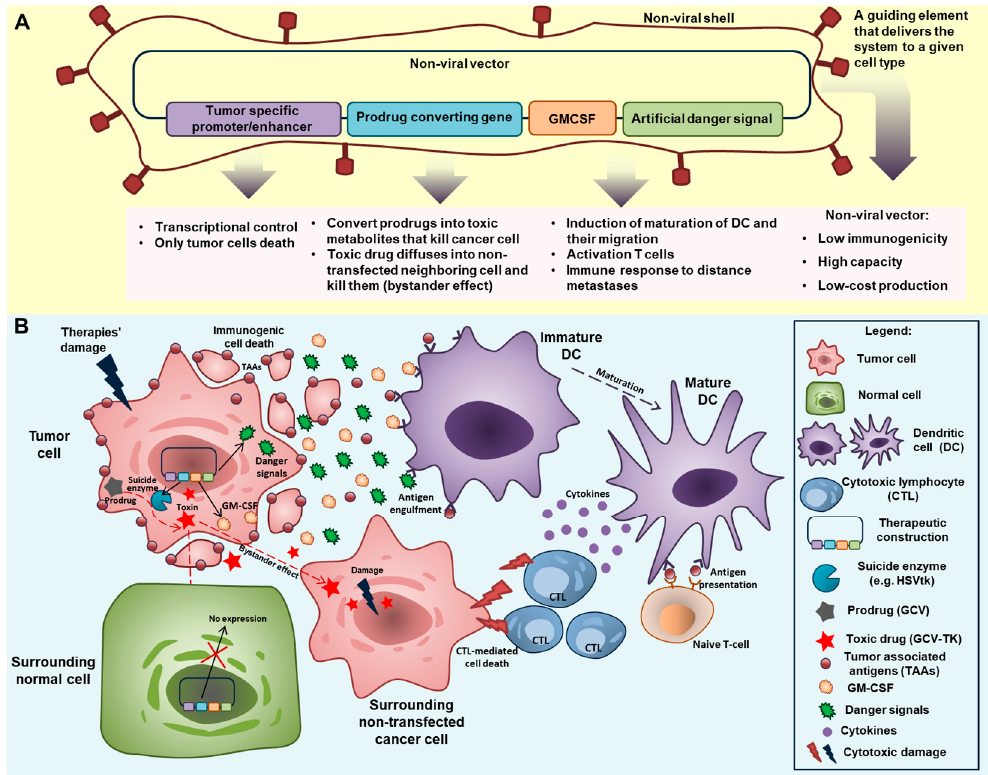
Figure 3. The “ideal” GDEPT system. ( A ) Components for improving the GDEPT system vector. A plasmid vector that encodes the suicide enzyme converting the prodrug to a toxin under the control of the tumor-specific promoter alongside GM–CSF plus an artificial danger signal as immunomodulators. The plasmid vector is coated by a non-viral shell with a guiding element that targets the system for a given cell type. ( B ) Mechanism of action of the “ideal” GDEPT system. A therapeutic construction administered intratumorally transfects the tumor cells because the guiding element of the non-viral shell and tumor-specific promoter/enhancer transgenes are restricted to expression in normal cells. In transfected tumor cells, the prodrug-converting gene (suicide enzyme gene) starts to be expressed and convert the prodrug (GCV or 5-FC) into toxic compounds (GCV-TK or 5-FU). The toxins cause apoptosis of the tumor cells and diffuse to the surrounding non-transfected tumor cells. Furthermore, this type of suicide gene therapy and its combination with chemo-/radiotherapies causes immunogenic cell death, thereby eliciting an immune response. Tumor-associated antigens are then released through immunogenic cell death and can activate dendritic cells and induce an adaptive antitumor response. GM–CSF and the danger signal co-expressed with the prodrug-converting gene enhance the activation of immunity. This combined impact leads to the induction of DC maturation and the migration of DCs to the tumor, the activation of T-cells, and the development of an immune response to distant metastases. All these factors lead to the effective destruction of tumor